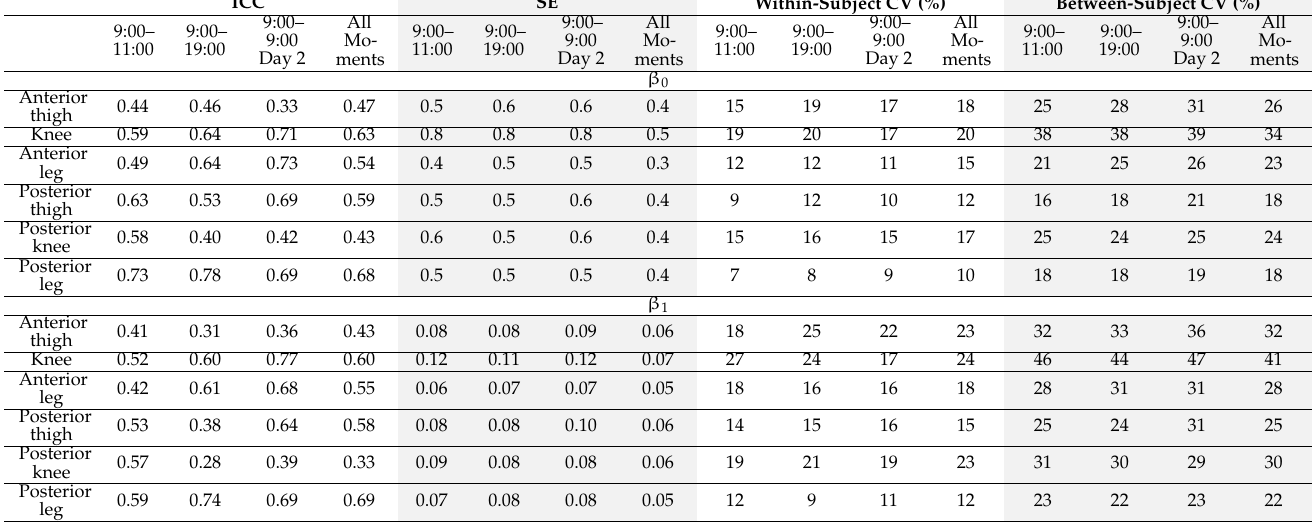
Table 1. Intraclass correlation coefficients (IC), standard error (SE), and within-subject and between-subject coefficient of variation (CV) of the measurement times comparisons, considering the coefficients of the logarithmic equations obtained with the cold stress test: Skin temperature variation ( ◦ C) = β 0 + β 1 × ln (time after the cold stress test (s)).